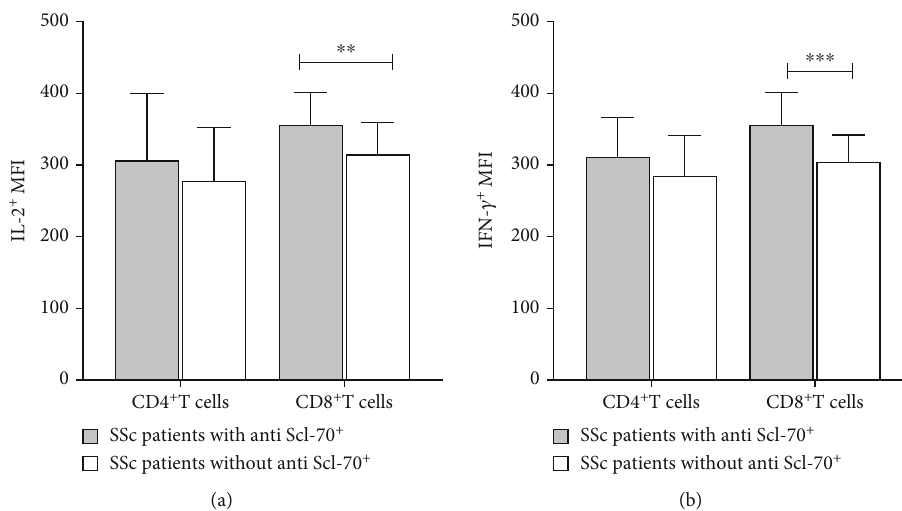
Figure 5: Interleukin-2 (a) and interferon gamma (b) expression of CD4 + and CD8 + T cells from SSc patients with and without anti-Scl-70 antibody following stimulation with pooled peptides derived from DNA topoisomerase-I protein. Data was expressed as mean fl uorescence intensity ð MFI Þ + SEM of positive cells (Student ’ s t -test, ∗∗ p < 0 : 01 and ∗∗∗ p < 0 : 001 ( n = 34 ; SSc patients with anti-Scl-70 antibody, n = 16 ; SSc patients without anti-Scl-70 antibody).